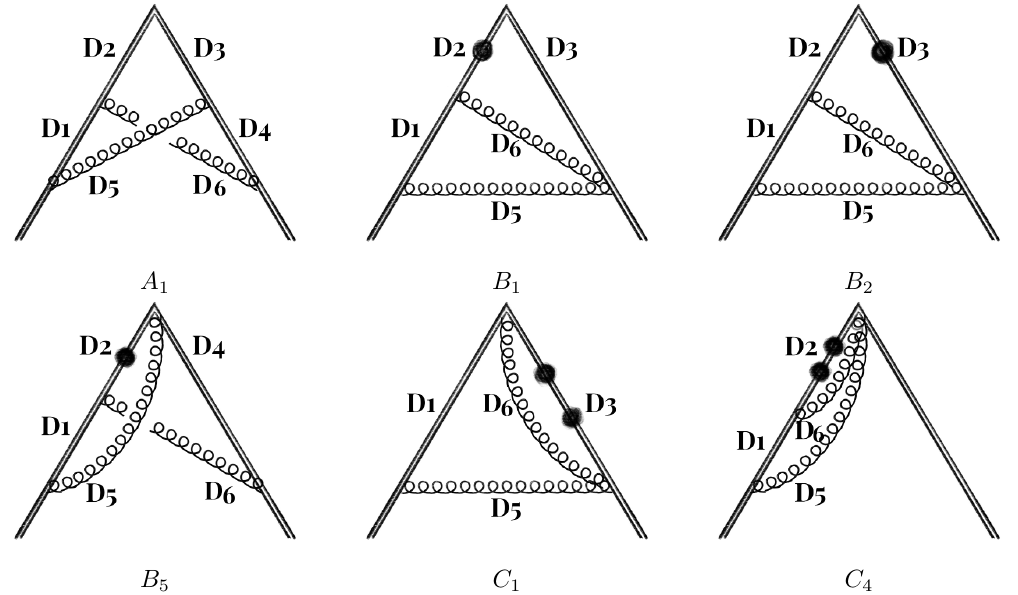
Figure 2. Admissible diagrams in the crossed ladder integral family. The dot stands for a doubled propagator. Further admissible integrals that involve numerator factors are given in the main